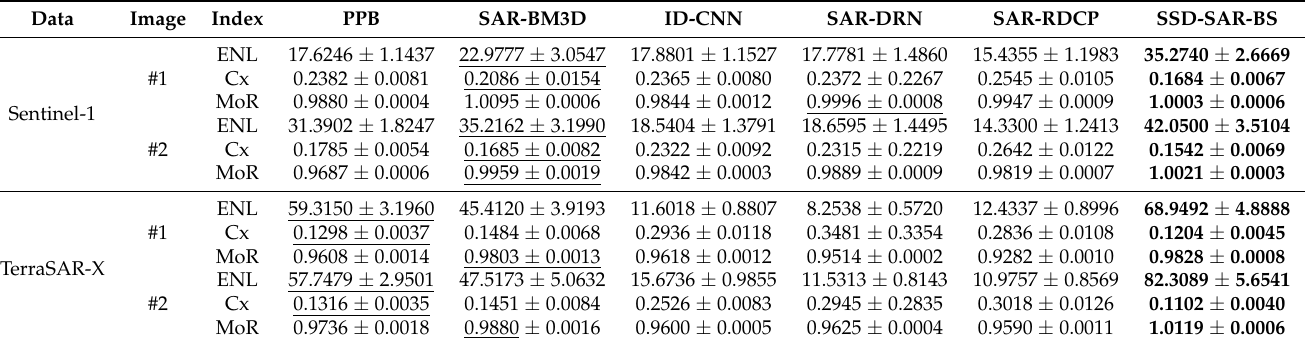
Table 3. Quantitative evaluation results on real SAR